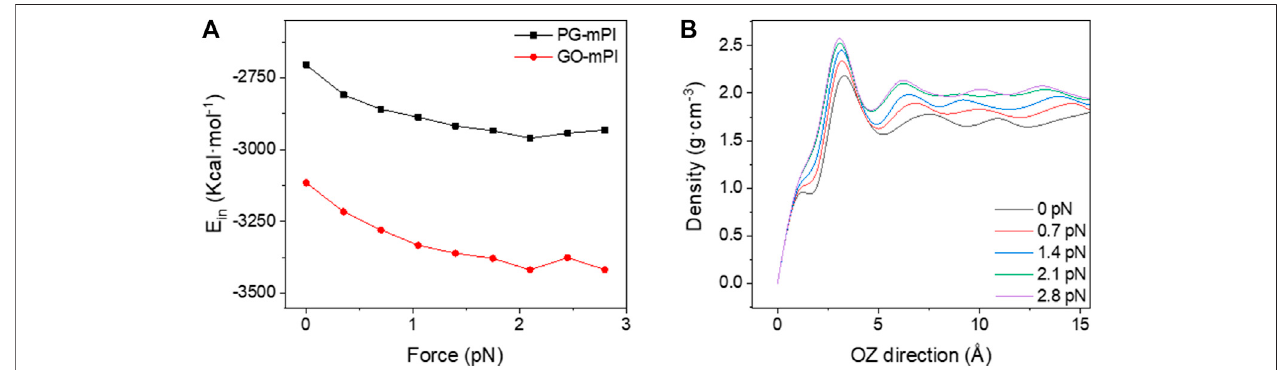
FIGURE 3 | (A) the interaction energies E in under different pressures; (B) density pro fi les of mPI/GO under different